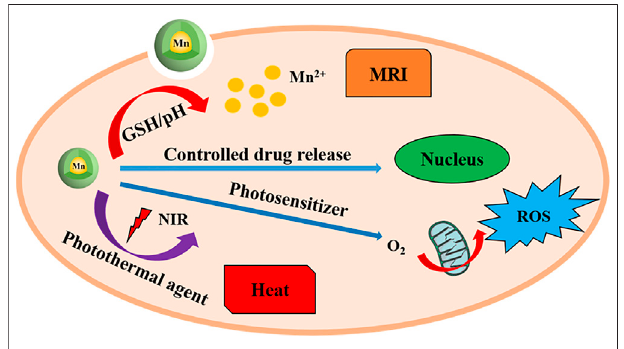
FIGURE 4 | The mechanism of Mn-NPs-based nanotheranostic agents for imaging guided chemotherapy/PDT/PTT and tumor MR